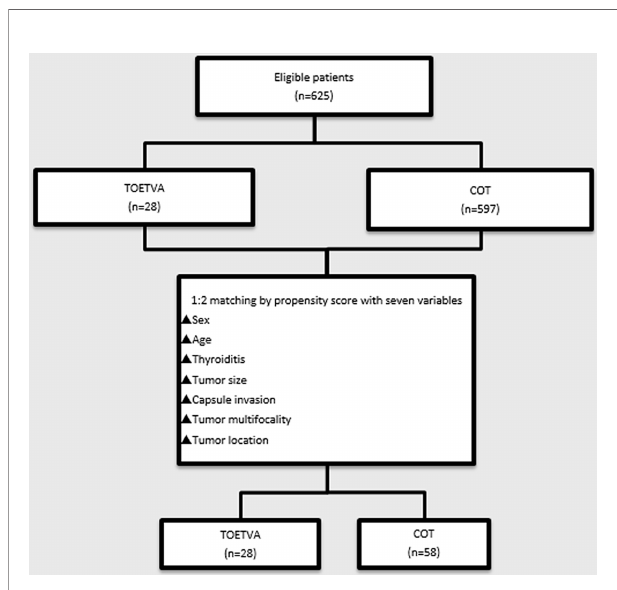
FIGURE 1 | Flowchart of propensity score-matching. TOETVA, transoral endoscopic thyroidectomy vestibular approach; COT, conventional open